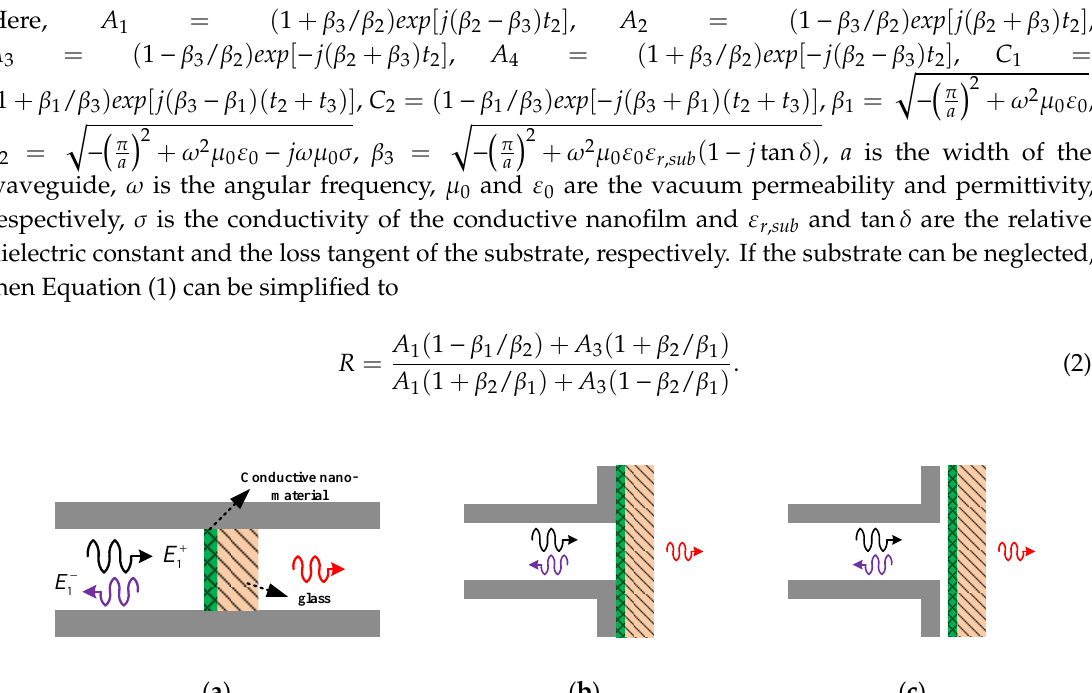
equation (1) simulation: contact case, 1.1 mm glass